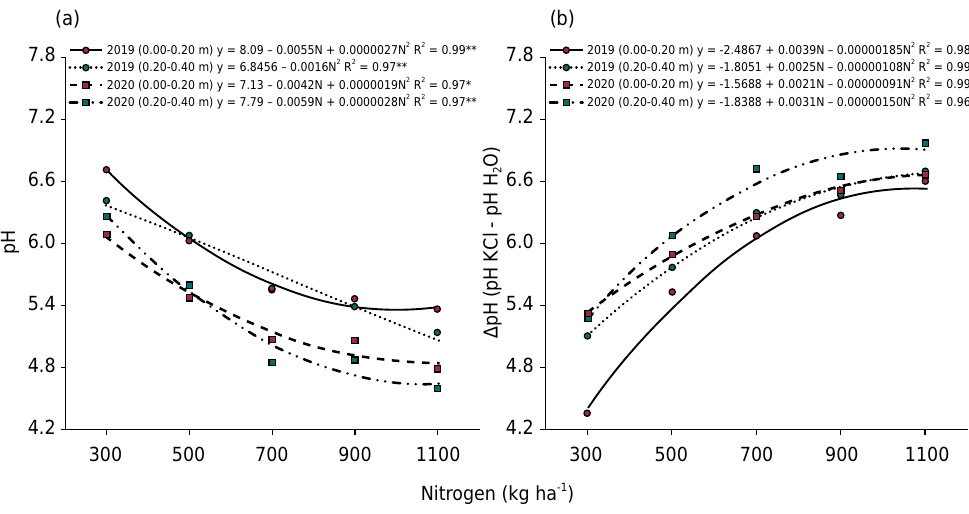
Figure 2. pH(H 2 O) (a) and ∆pH [pH(KCl) – pH(H 2 O)] (b) at layers of 0.00-0.20 and 0.20-0.40 m in the soil cultivated with Conilon coffee, in response to the application of nitrogen doses. * and **: significant at 5 and 1 % probability, respectively.